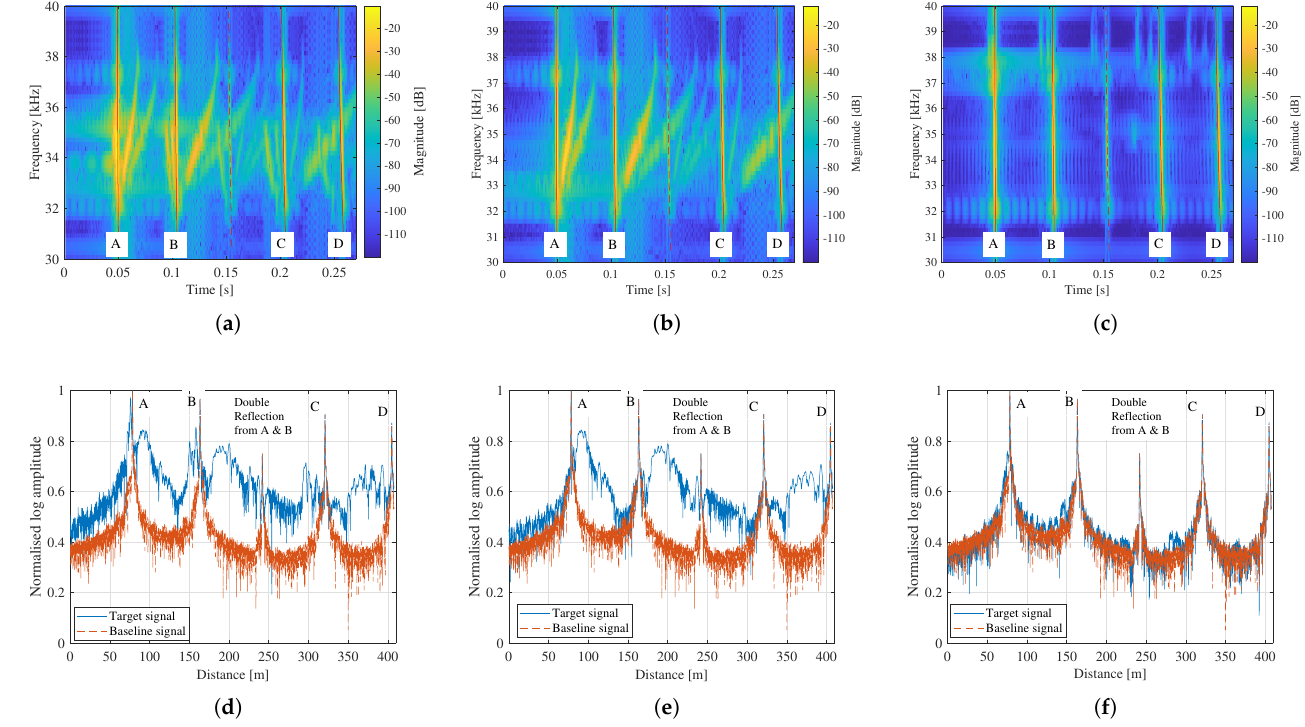
Figure 5. Spectrograms and the equivalent distance domain signals, for example, target signals with different mode combinations. ( a , d ) Modes {7, 8, 15, 16, 21, 22}, ( b , e ) Modes {7, 15, 16} and ( c , f ) Modes {7, 8, 9, 23,